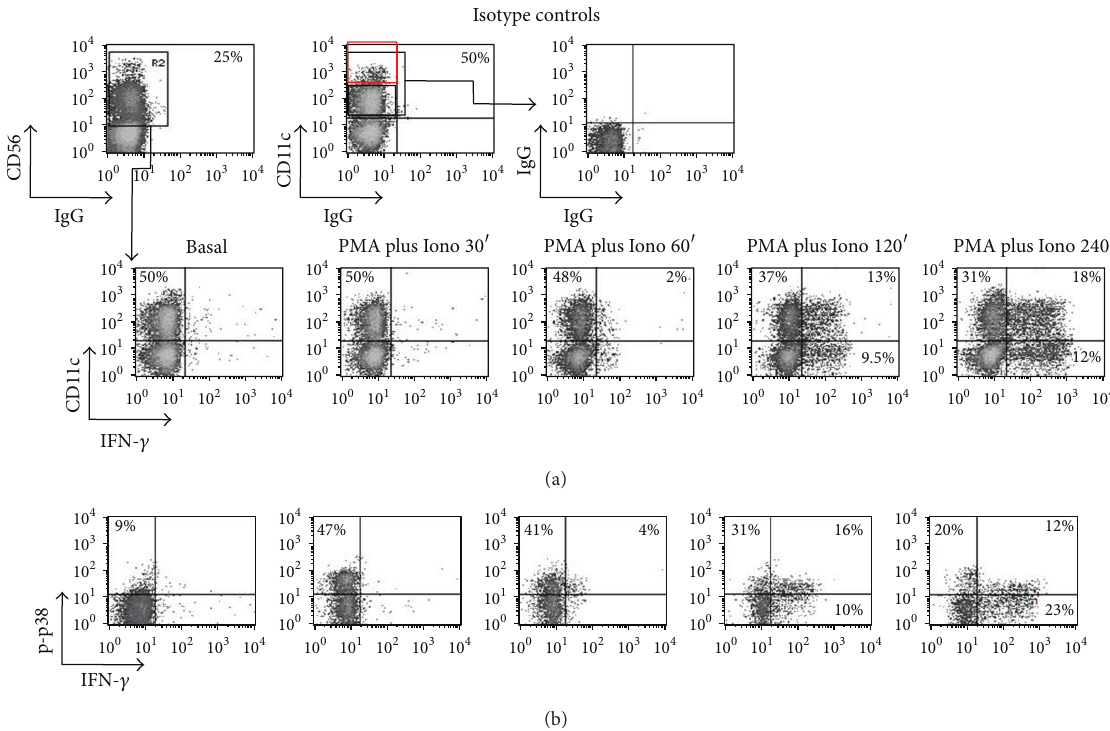
Figure 6: Simultaneous detection of IFN- 𝛾 and p-p38 MAPK expression in CD56+ CD11c+ cell populations. PBMCs were stained with MoAbs against CD56, CD11c, p-p38, and IFN- 𝛾 . CD56+ cells were subgated and the percentage of CD11c+ within CD56+ cells is shown. (a) Gated CD56+ cells were plotted for CD11c versus IFN- 𝛾 in order to assess IFN- 𝛾 expression within CD11c+ cells. (b) Gated CD56+ CD11c+ cells were plotted for IFN- 𝛾 versus p-p38 to measure double positivity for p38 and IFN- 𝛾 . A significant expression of early IFN- 𝛾 is detected within the CD11c+ CD56+ cell